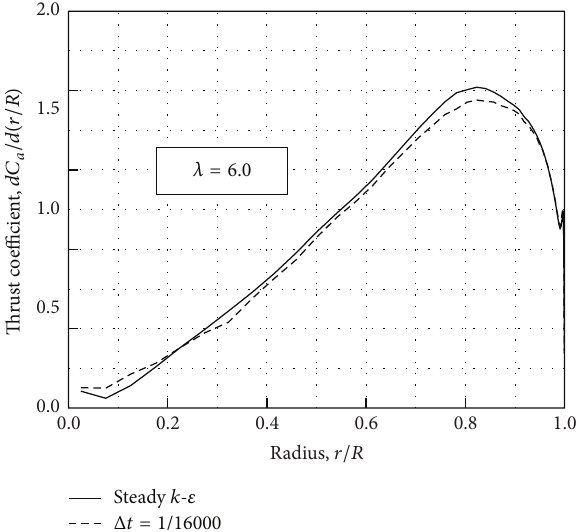
Figure 10: Local thrust coefficient for tip speed ratio 𝜆 = 6 .